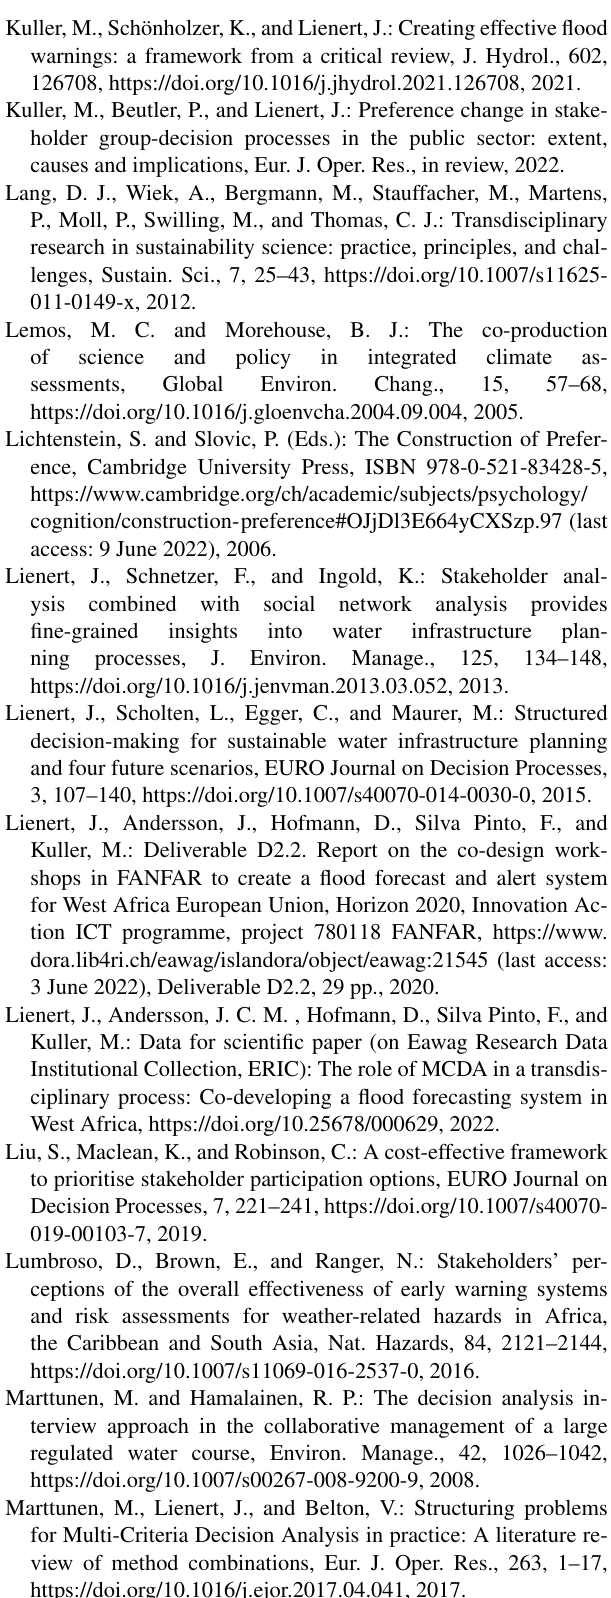
Figueira, J. and Roy, B.: Determining the weights of criteria